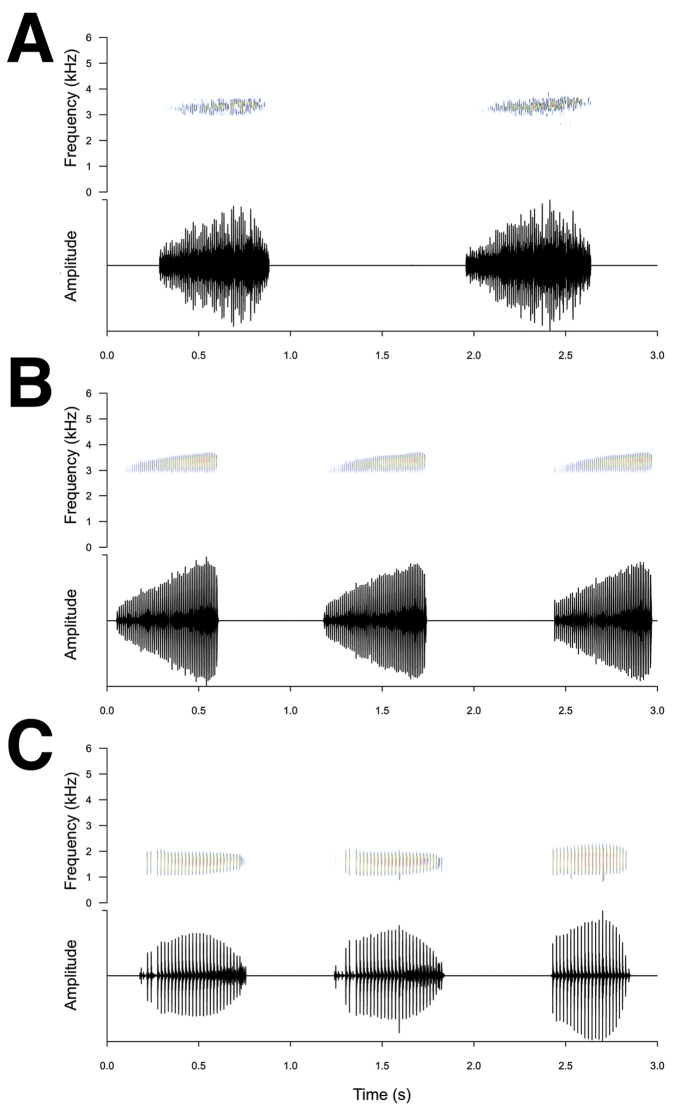
Advertisement call of Phrynobatrachusbibita sp. n. Spectrograms (upper panels) and sonograms (lower panels; relative amplitude) of Ethiopian Phrynobatrachus advertisement calls. APhrynobatrachusbibita sp. n. (specimen not collected) BP.minutus (SB233) CP.natalensis (specimen not collected).